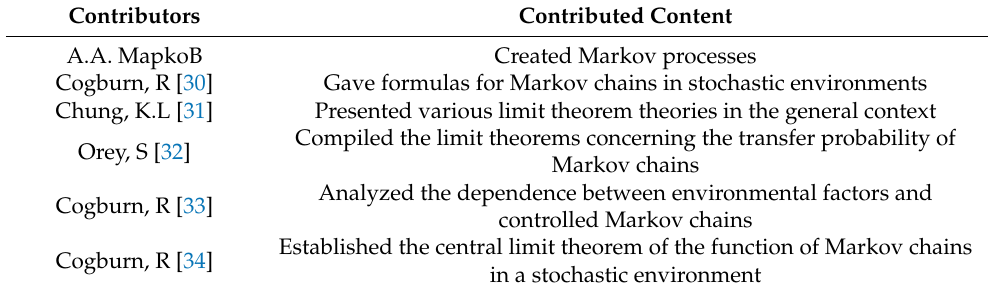
Table 1. The evolution of Markov processes.